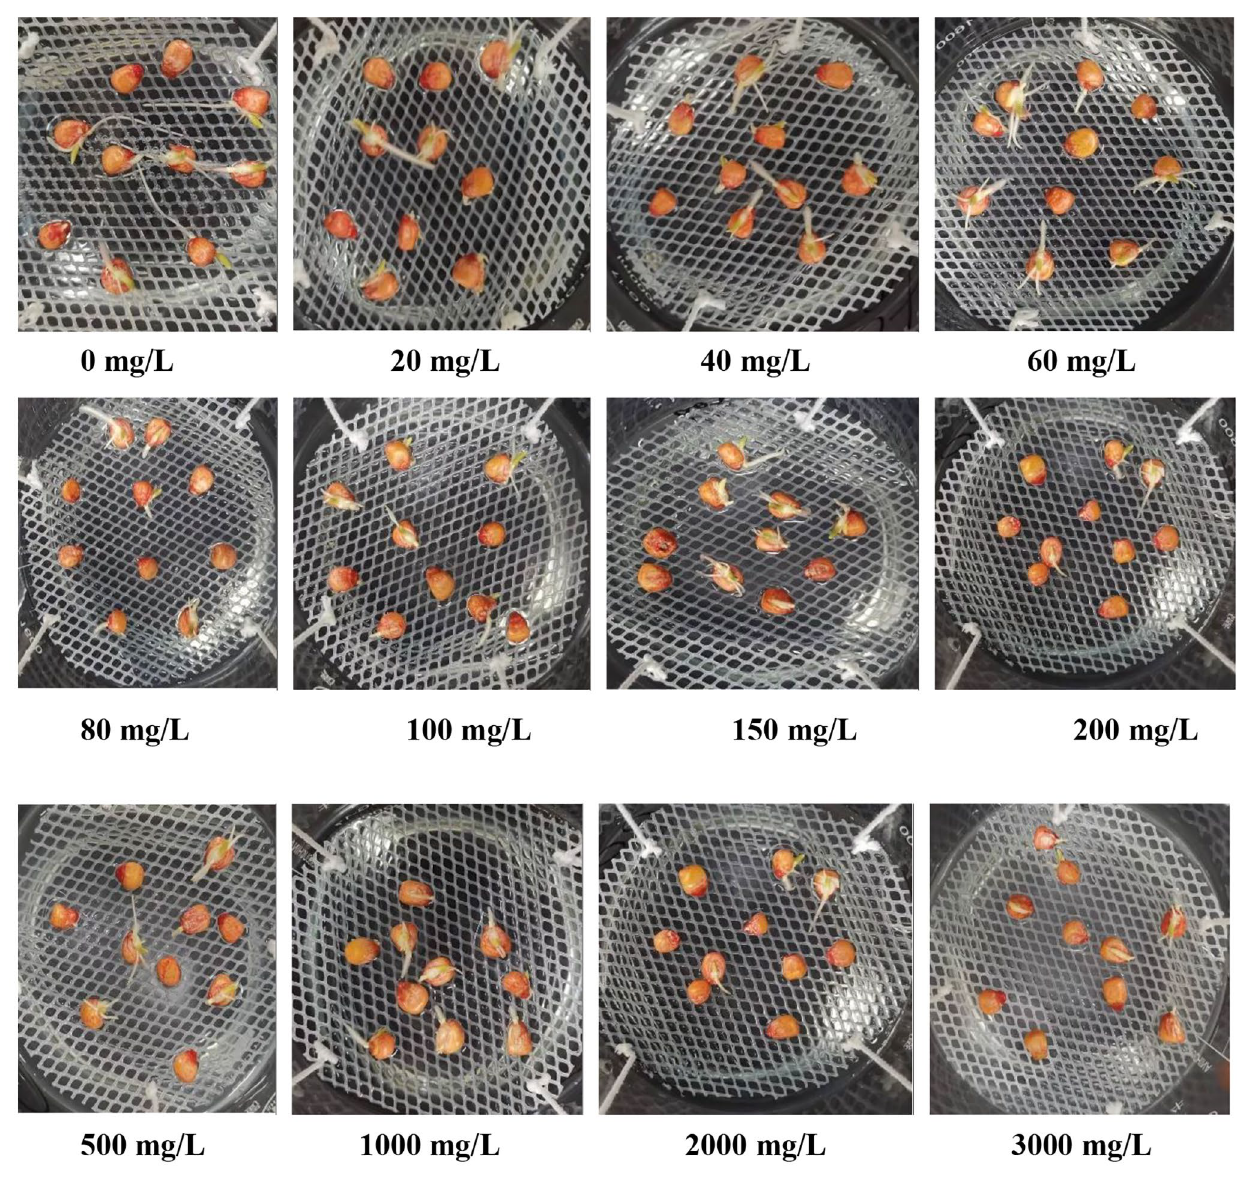
Fig. 1 Nutrient solution culture of maize in 3